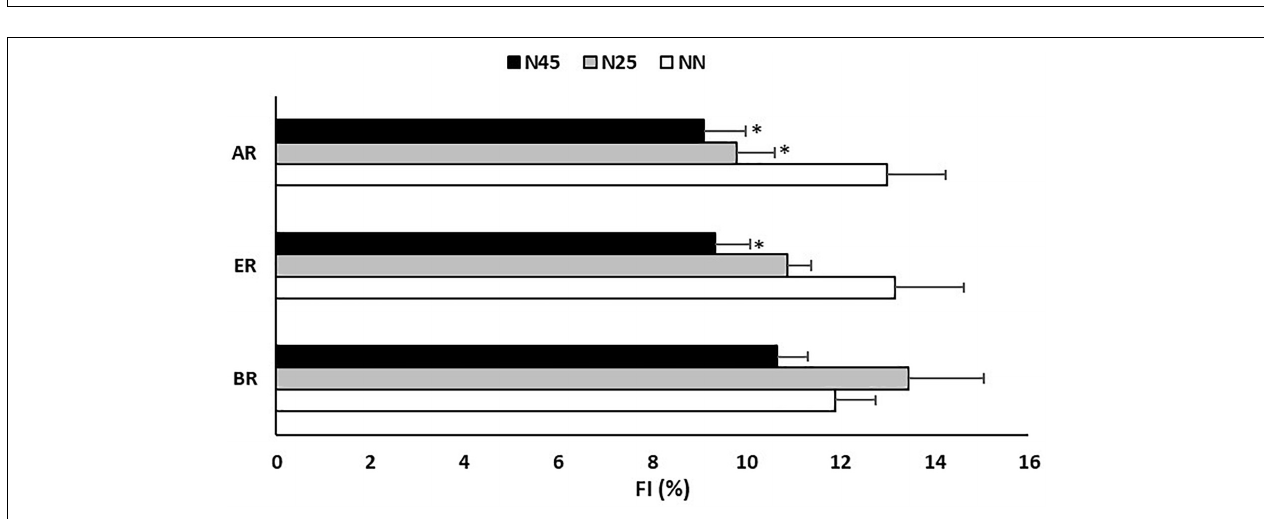
FIGURE 3 | Total distance (TD) recorded during the 5-m shuttle run test in the no-nap condition (NN), the 25-min nap condition (N25), and the 45-min nap condition (N45), before (BR), during (ER), and after (AR) Ramadan. ∗ : Significant difference in comparison with NN; #: Significant difference in comparison with N25; $: Significant difference in comparison with